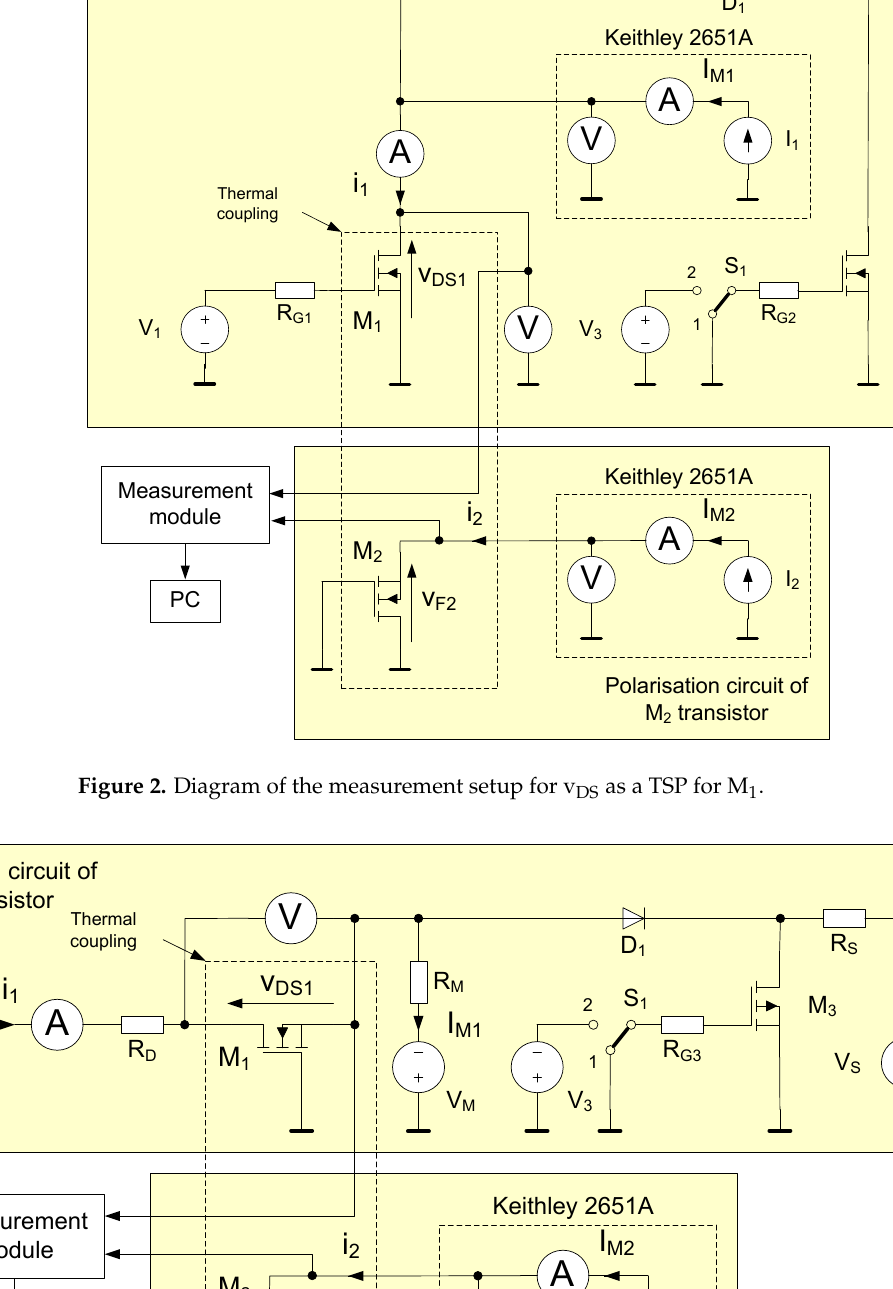
GS as a TSP for M 1